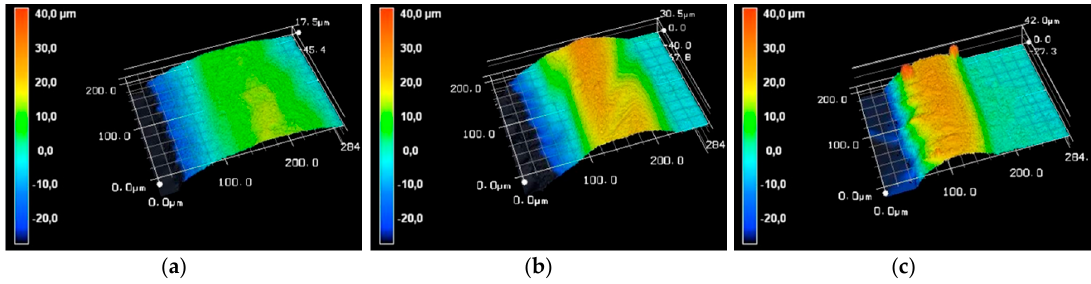
Figure 7. Laser scanning microscope sections of a laser cut lithium sheet: 72.8 W, 490 kHz, 240 ns; ( a ) 75 mm/s, PO 99.83%; ( b ) 100 mm/s, PO 99.77%; ( c ) 150 mm/s, PO 99.66%.